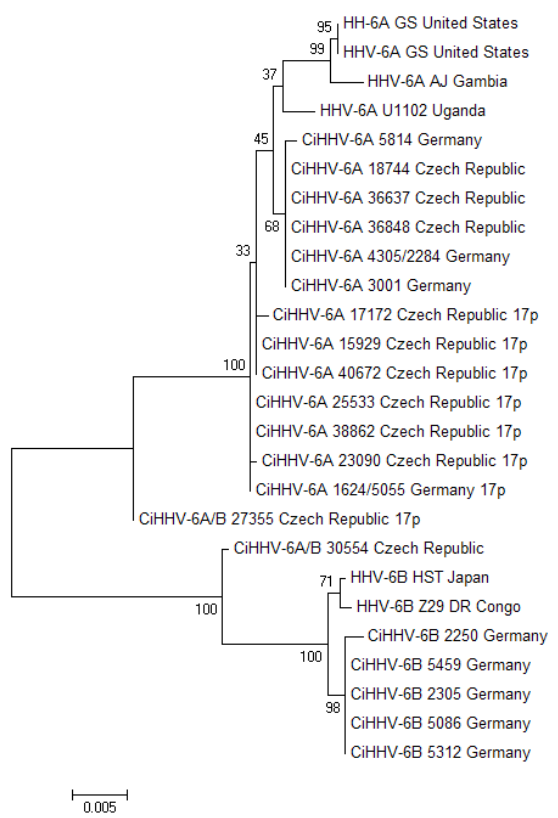
Figure 4. Phylogenetic relationship of coding sequences from patients with CiHHV-6A integrated at the subtelomere of human chromosome 17p. Sequences from the 4 genes were described previously from both CiHHV-6A and CiHHV-6B patients [21]. The sequences were then catenated and phylogenetic reconstructions made (see Figure 2). CiHHV-6A/B indicated intergenic recombinants previously identified [21]. Comparisons are made to sequences from known HHV-6A and HHV-6B genomes. Bootstrapping was conducted with 1000 replicates, and percentages are indicated at the nodes. Branch lengths were measured in number of substitutions per site as indicated by the scale.